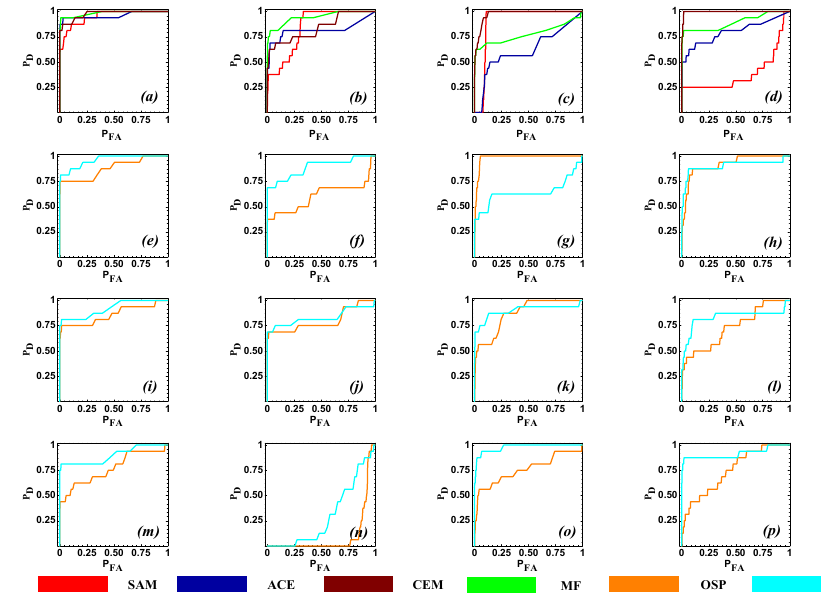
Figure 9. Target detection performance comparison in airborne imagery for the terrestrial hyperspectral imager (THI) target reference spectra. ROC curves for the detection from SAM, ACE, CEM, and MF for the ( a ) N1G, ( b ) N2R, ( c ) N3Y, and ( d ) N4B targets. ROC curves for the subspace-based detector OSP and TCIMF for the N1G, N2R, N3Y, and N4B targets for ( e – h ) 5, ( i - l ) 10, and ( m – p ) 15 endmember/background materials.